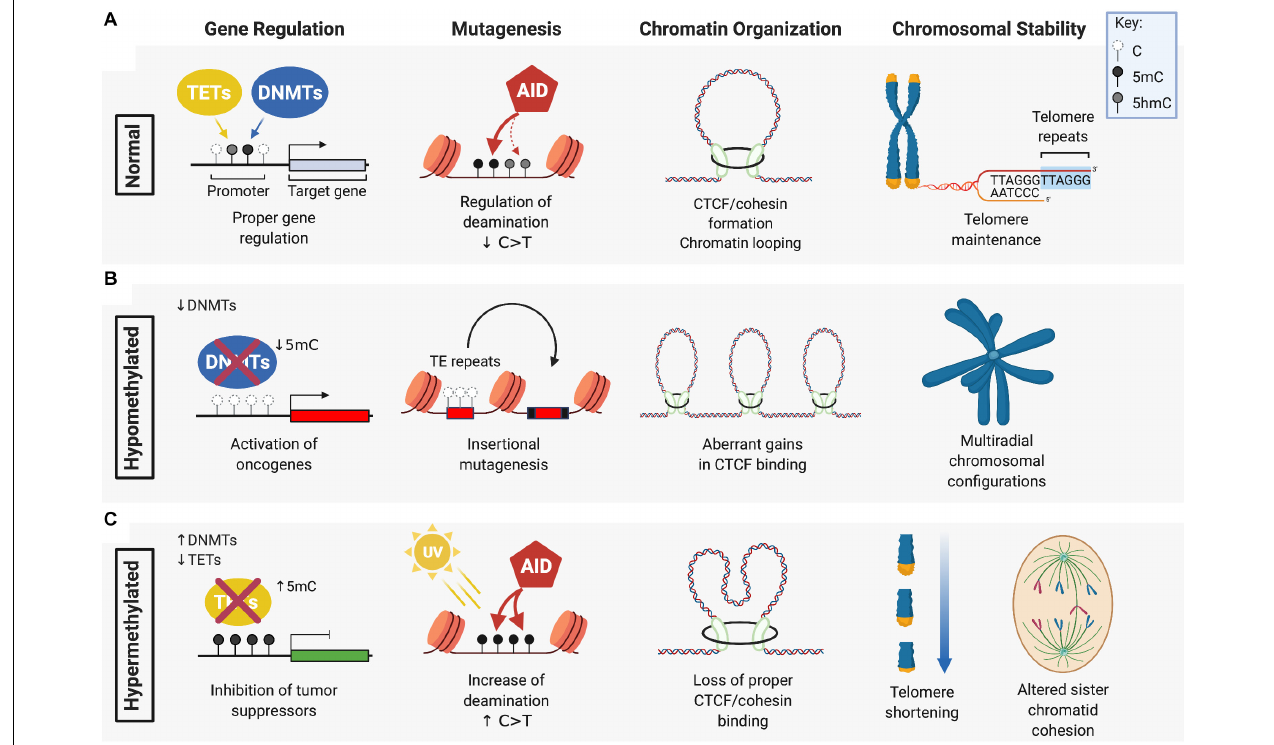
FIGURE 1 | The role of DNMTs and TETs in DNA methylation maintenance and genomic stability. (A) DNA methyltransferases (DMNTs) regulate the methylation of cytosine residues (white) in CpG islands typically found in the promoter region of target genes, while Ten-Eleven Translocation (TET) enzymes promote the demethylation of 5-methylcytosines (5mC) (black). Together, these enzymes regulate normal DNA methylation patterns and genomic stability by ensuring: proper silencing and activation of gene expression; cytosine deamination by AID or APOBEC (not shown) that preferentially target 5mC over C/5hmC (gray) for C > T transition; CTCF/cohesin-guided boundaries between enhancers and promoters of genes; and maintenance of telomeres. (B) DNA hypomethylation, caused by a loss of function of DNMTs, can lead to: aberrant oncogene activation by removal of promoter silencing; upregulated activity of transposable elements (TE) that drive insertional mutagenesis; gains in CTCF binding that exacerbate oncogene expression; and loss of heterochromatin at peri-centromeric regions causing defective chromosome segregation and multi-radial configurations (specifically seen in ICF patients with DNMT3B mutation). (C) DNA hypermethylation is associated with: aberrant silencing of tumor suppressors from increased DNMT activity or loss of TET function; an increased frequency of C > T transitions due to enhanced mutagenicity and deamination of 5mC; loss of CTCF/cohesin binding leading to gene mis-regulation; and telomere shortening and altered sister chromatid cohesion. Figure created with